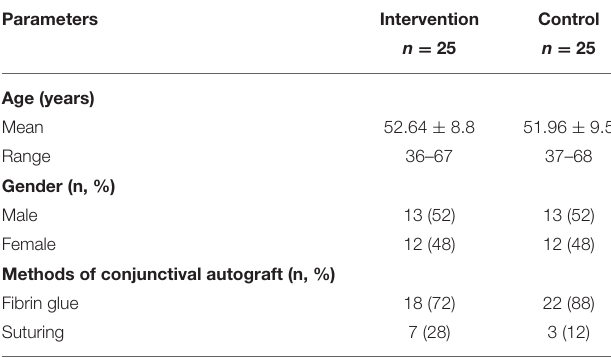
TABLE 1 | Distribution of age, gender, and method of conjunctival autograft for both groups.